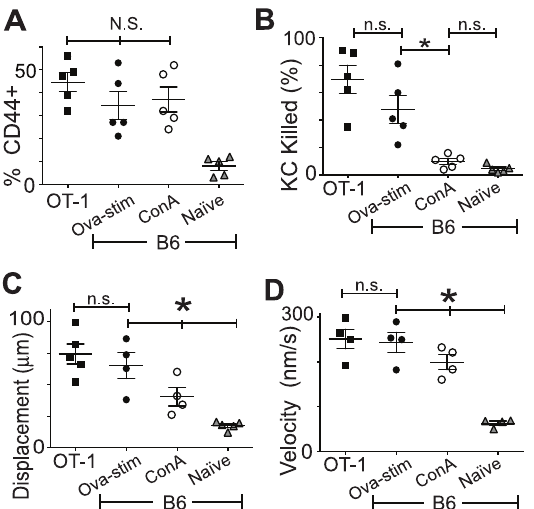
Figure 4. CD8 + T cell activation is sufficient to promote enhanced kinematics. CTL from OT-1 mice (OT-1), or from B6 mice either immunized with OVA and stimulated with SIINFEKL (Ova-stim), or stimulated with concavalin A (ConA), or not stimulated (Naı¨ve), were added to KC cultures loaded with SIINFEKL and imaged for 30 h. A . CTL were isolated by FACS based on size and granularity and by EGFP and CD8 expression, and stained for CD44. Percentage of isolated cells that are CD44 + are shown. B . Percentage of total KC that were killed after 30 hours of co-culture with different groups of CD8 + T cells. KC killing was determined by red fluorescence change indicating activation of caspase-3. C . Vector displacement and velocity ( D ) of the effector cells added to antigen-presenting KC over 30 hours of imaging. (A–D N=5, error bars SEM) (n.s. not significant, *p , 0.05; N.S. no significant difference between indicated groups, *p , 0.05 between indicated groups ANOVA.).